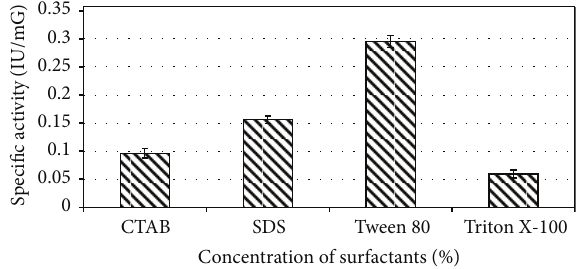
Figure12:EffectofsurfactantsonspecificADIactivityby E.faecium sp. GR7. Results are expressed as the mean ± S.D ( 𝑛 = 3 ), 𝑃 -value <